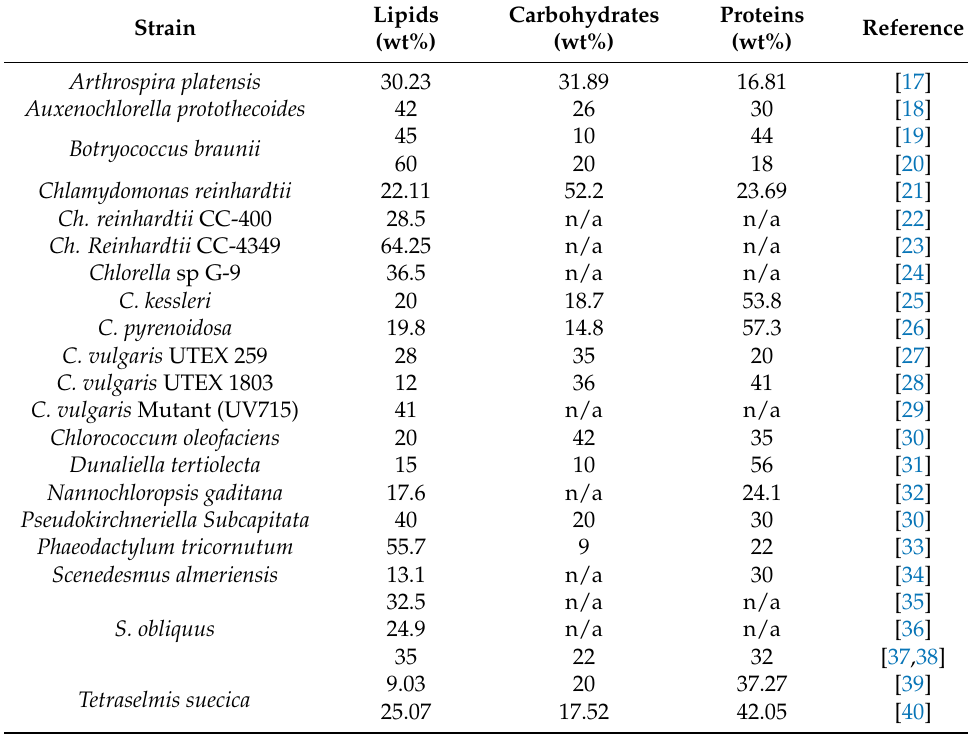
Table 1. Different strains studied for biodiesel